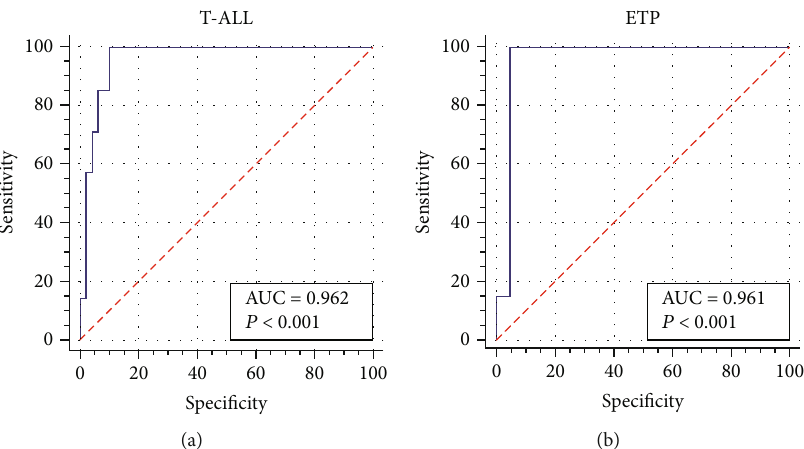
Figure 4: Receiver operating characteristic (ROC) curve for the multivarivate model of mixed infection in the T-ALL (a) and ETP-ALL (b)